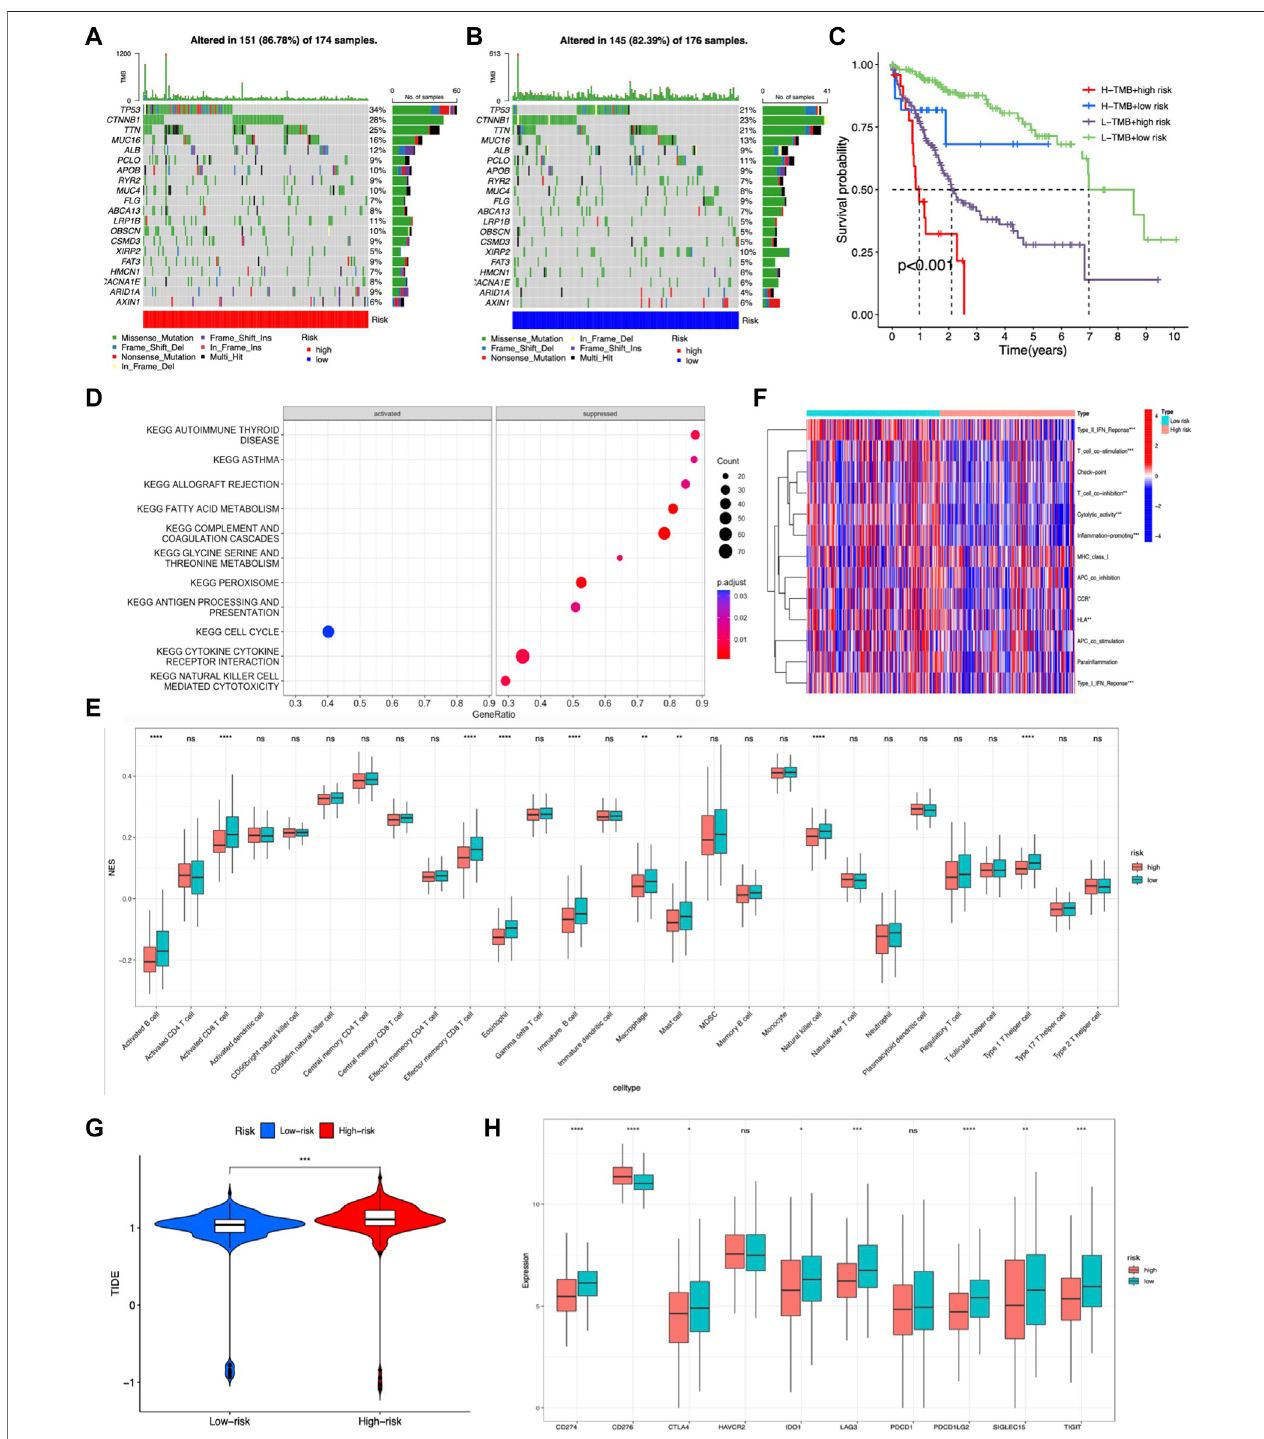
FIGURE 8 | Evaluation of the tumor immune landscape and immunotherapy response based on the m7G-related lncRNA model in the entire LIHC set. (A,B) Waterfall plot displayed top 20 mutation genes ’ information in the two risk groups. (C) KM survival analysis of OS strati fi ed by tumor mutation burden and the m7G- related lncRNA model. (G) TIDE prediction differencebetween tworisk score subgroups. (D) Signi fi cant KEGG pathways enriched in high-risk patients. (E) Difference in tumor in fi ltration immune cells based on ssGSEA scores between two risk groups. (F) Difference in immune-related functions based on ssGSEA scores between two risk score subgroups. (H) Expression of immune checkpoint blockade-related genes between the two risk groups.